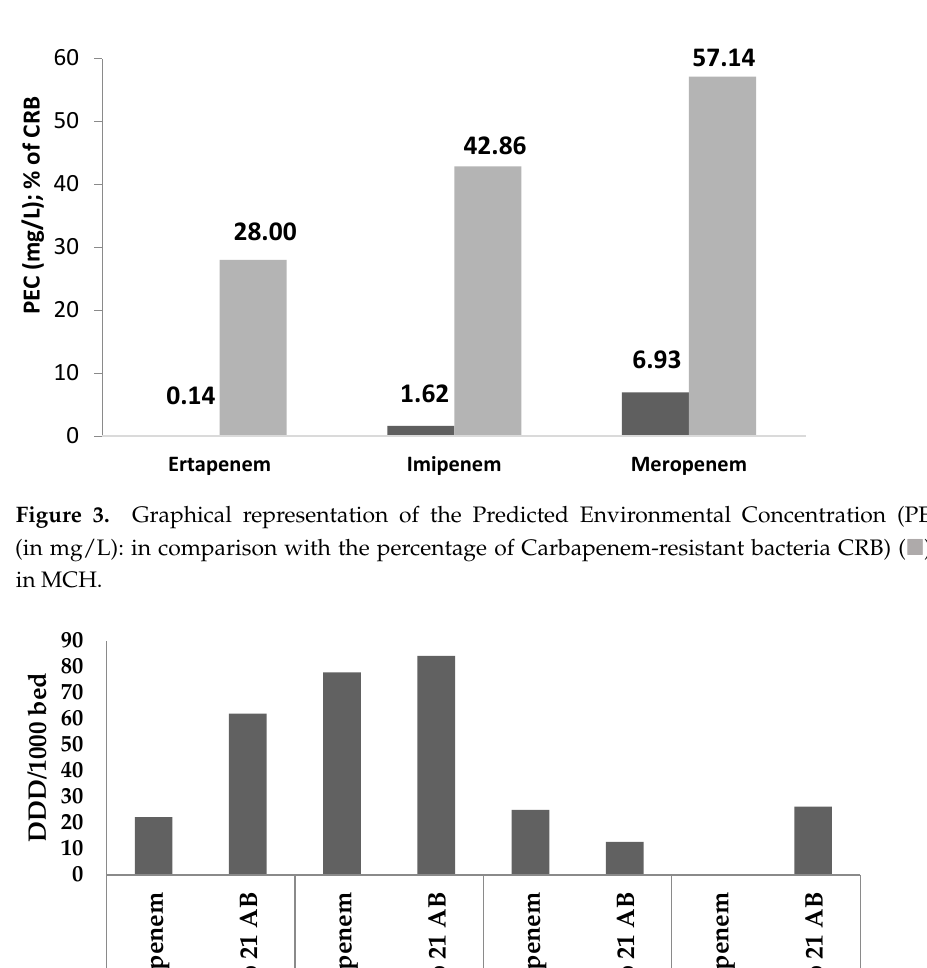
Figure 4. Seasonal variation in the percentage of antimicrobial resistance in MCH effluents.